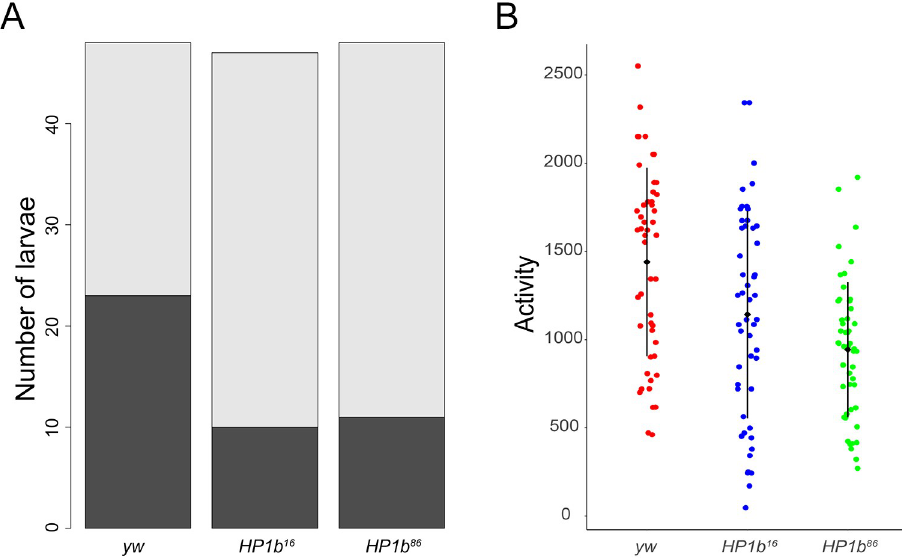
control (p < 0.001 for both comparisons; chi-square test). Dark grey: animals that moved; light grey: animals that failed to move. Y-axis: Number of larvae. N = 47–50 per genotype. B . Adult animals lacking HP1B show significantly lower activity levels than animals of the yw control genotype (p < 0.001 for both comparisons; Tukey’s HSD). Y-axis: activity level as measured by recorded beam crossings in an activity monitor for 10 flies within a 2hr assay period. Black diamond and bar: mean +/- SD. N = 50 per